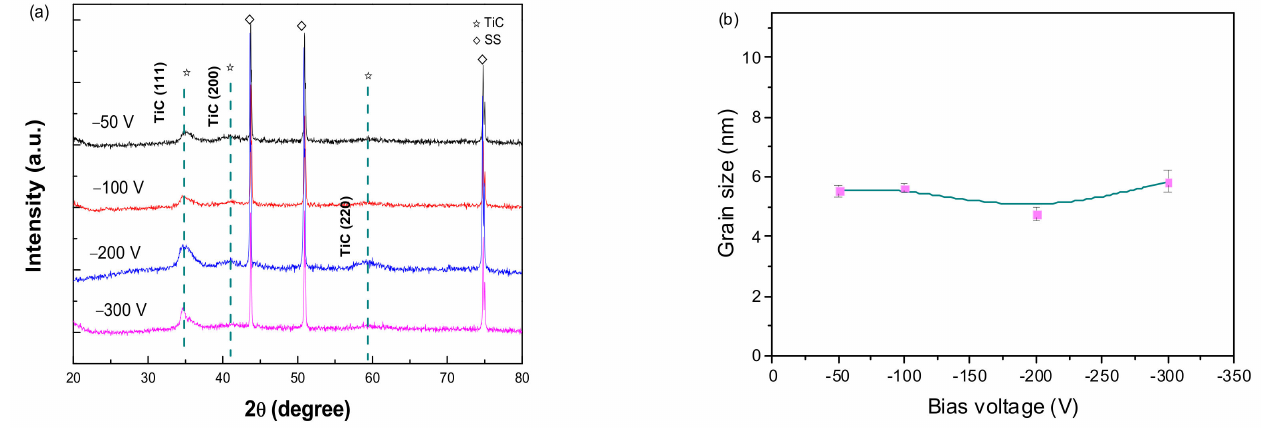
Figure 4. XRD pattern ( a ) and average grain size ( b ) of as-prepared Ti-DLC